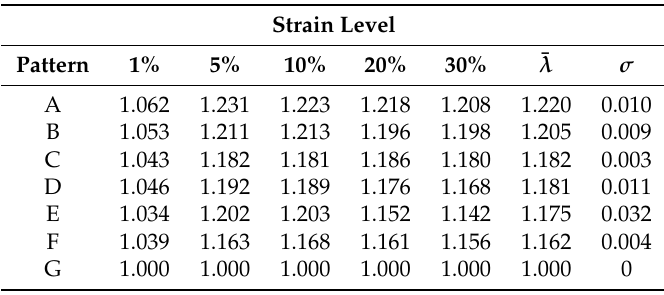
Table 2. Numerical gauge factors λ as a function of strain levels under each patterns, along with average gauge factor ¯ λ and sample standard deviation ( σ )